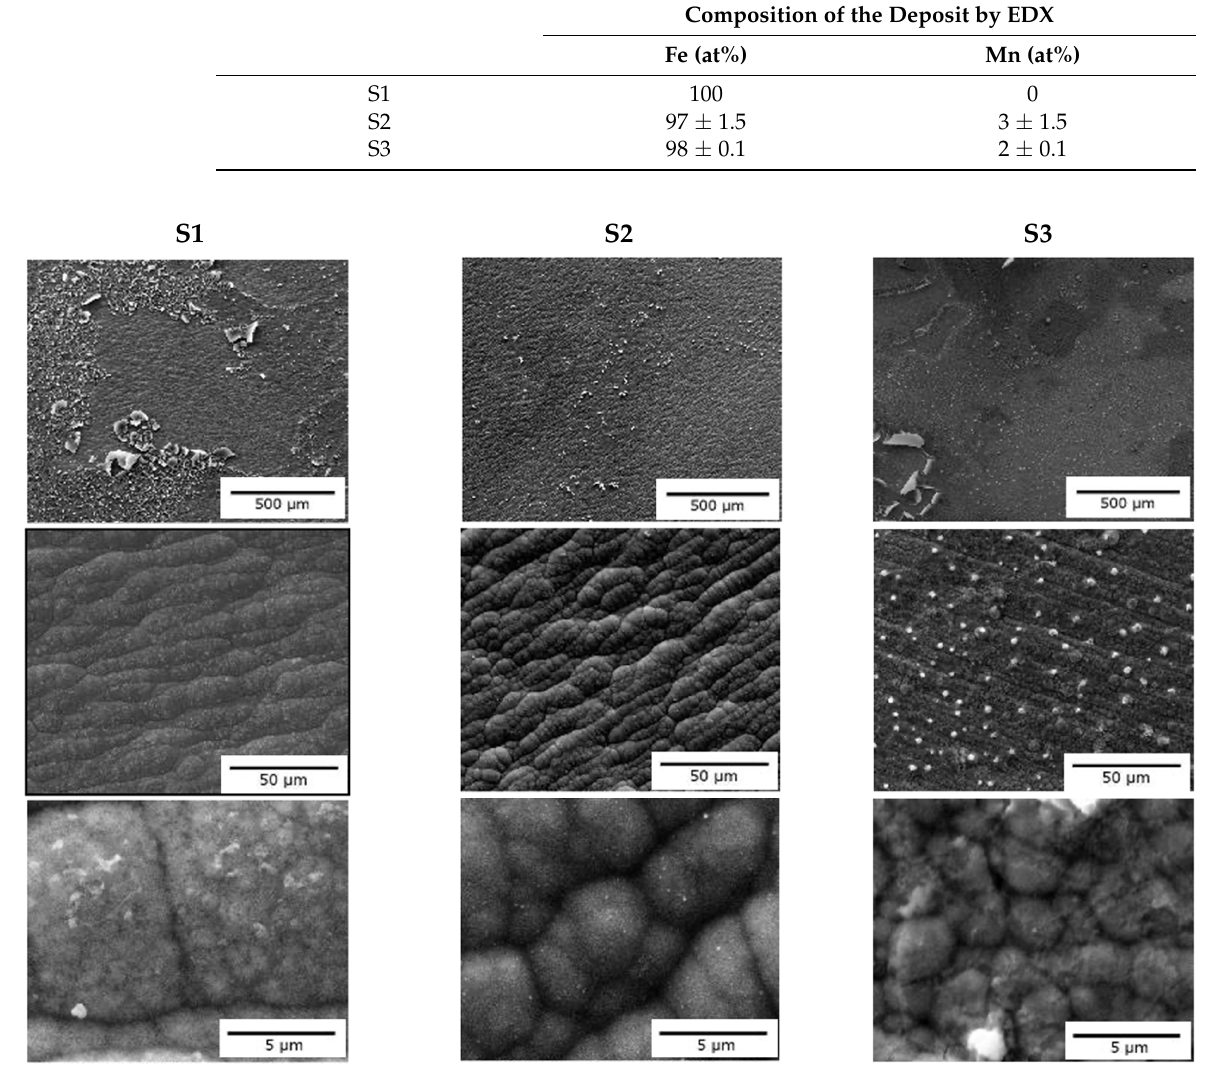
Figure 3. SEM images of the surface of deposits obtained for different concentrations of Fe–Mn and magnification of ( a ) 100×, ( b ) 1000×, and ( c ) 10,000×.